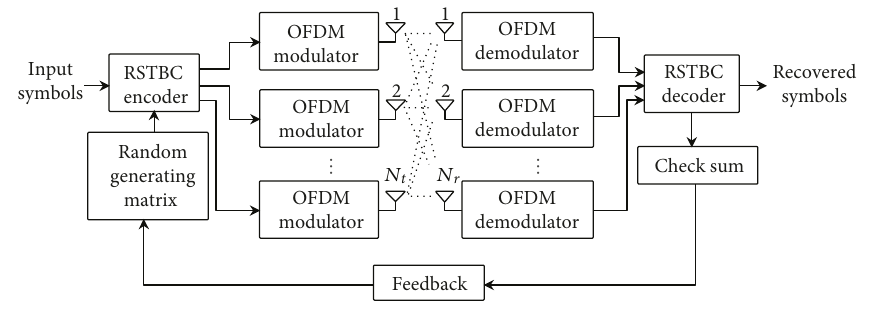
Figure 1: A general MIMO-OFDM system with